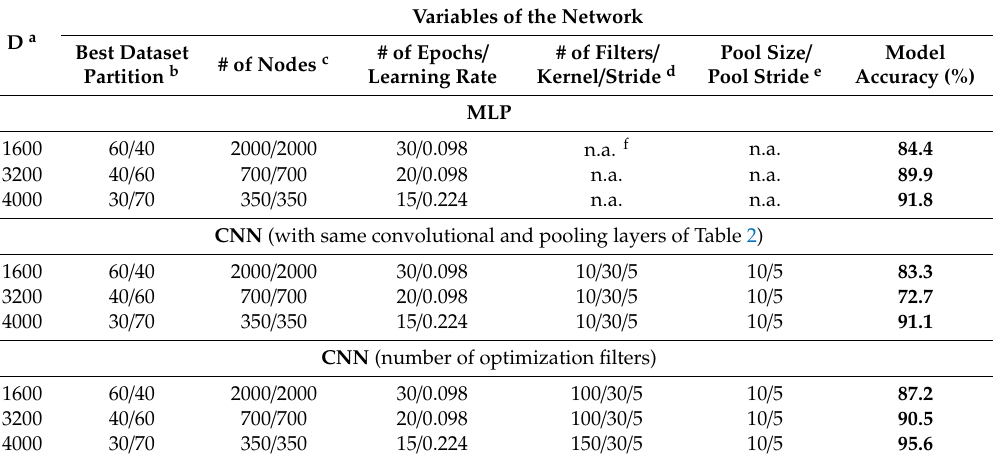
Table 3. Comparison of